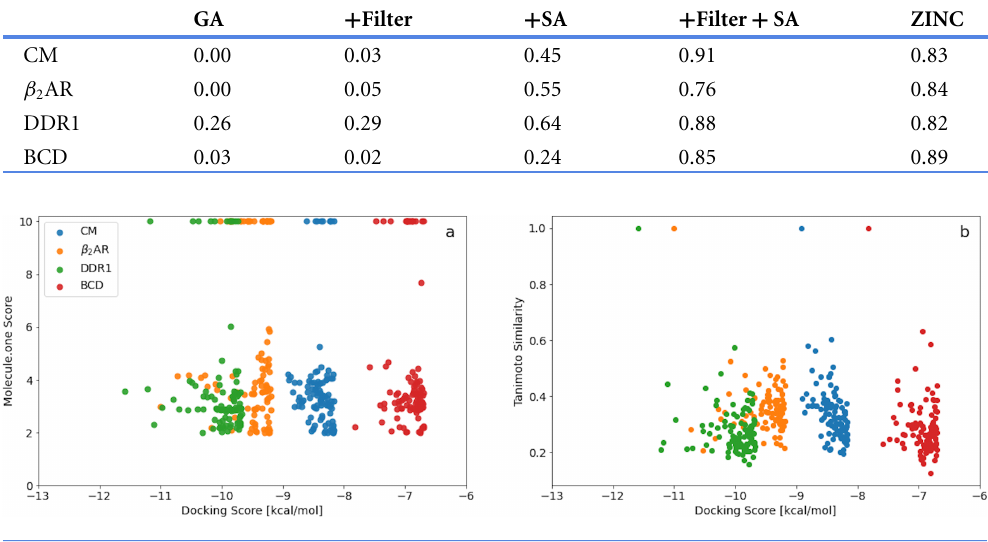
Figure 2 (A) Molecule.one score versus docking score for the 100 best binders predicted for the four different targets using Filters and SA. (B) ECFP4 Tanimoto similarity to the best scoring molecule for each target vs docking score for the 100 best binders predicted for the four different targets using Fil- ters and SA. Full-size DOI: